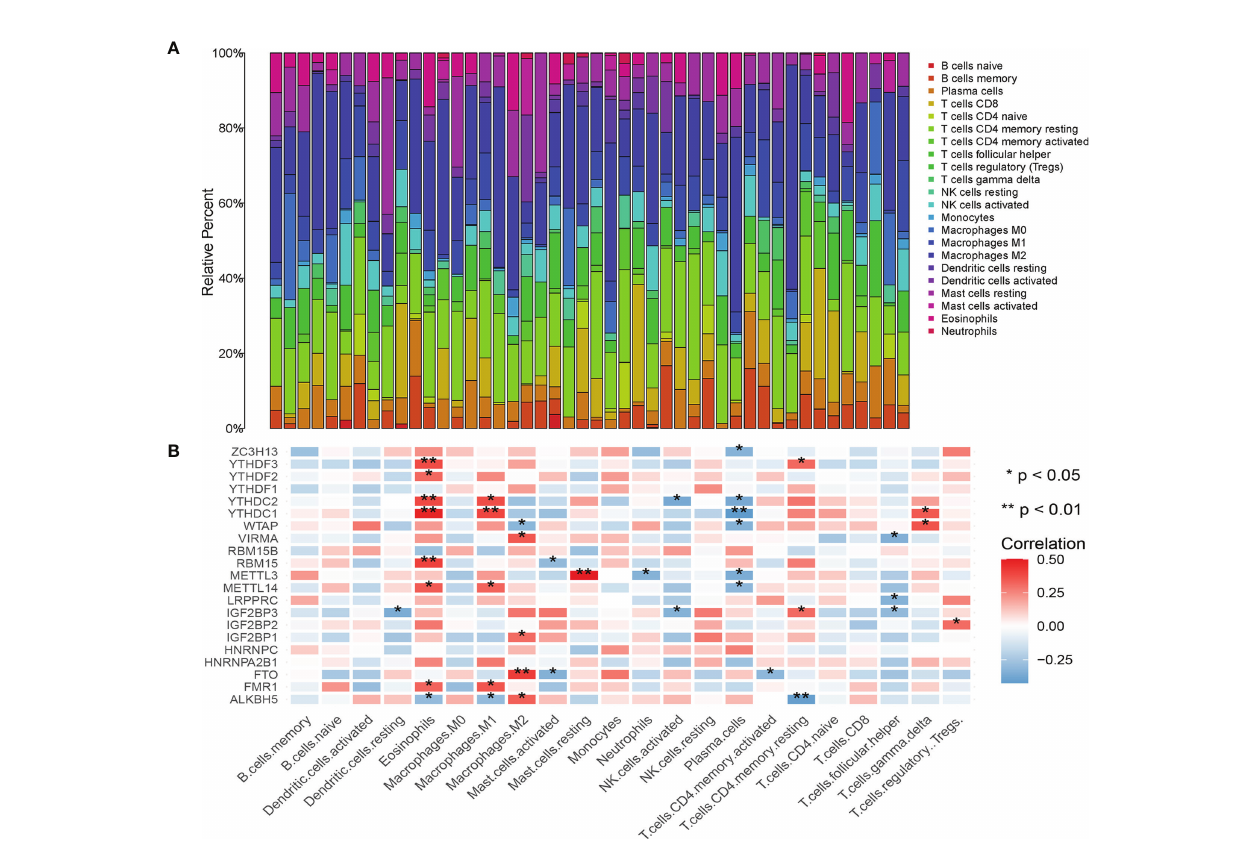
FIGURE 4 | (A) Histogram of percentage of immune cell subtypes in skin melanoma samples; (B) Correlation analysis between m6A related genes and immune